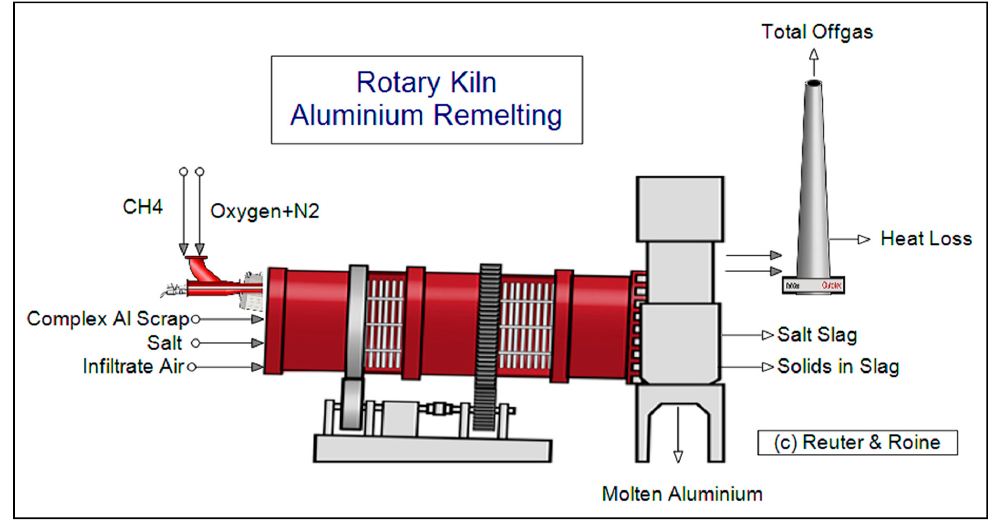
Figure 5. HSC Sim ® simulation process diagram of the Al-recovery pyrometallurgical process.